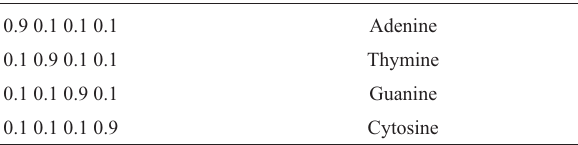
Table 1 - Nucleic bases